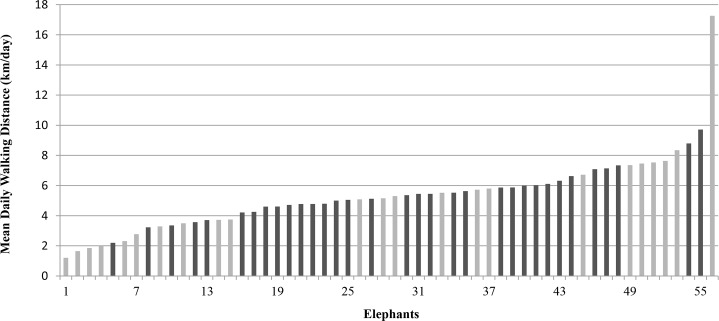
Mean daily walking distance in zoo elephants.Black bars indicate African (n = 33), grey bars indicate Asian (n = 23).